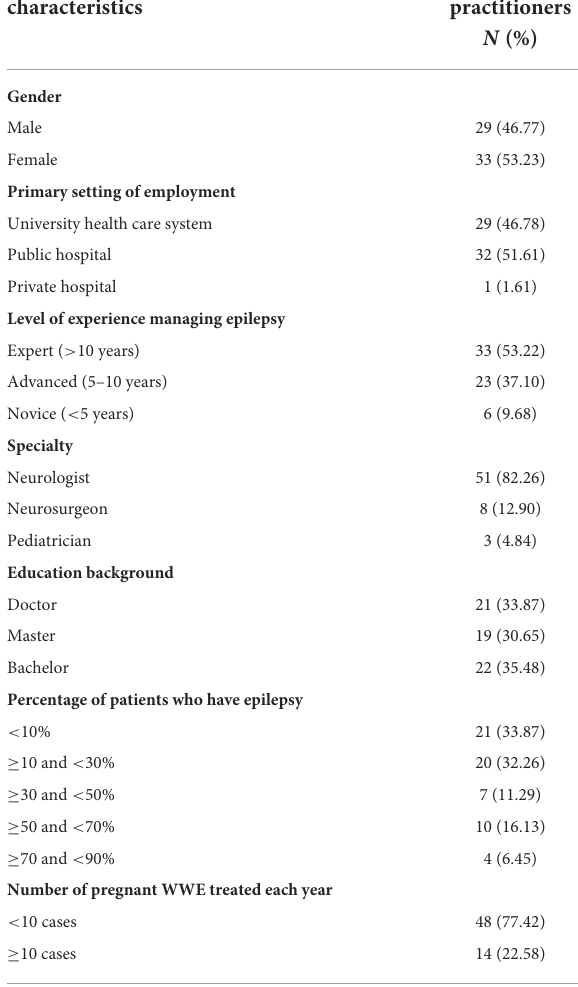
TABLE 1 Demographic characteristics of surveyed